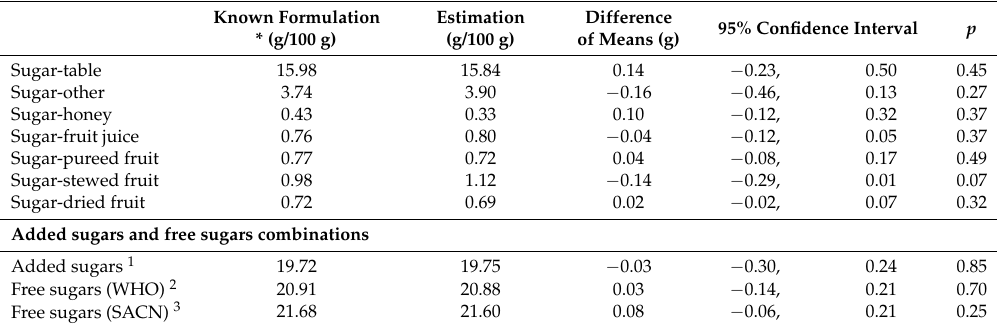
Table 2. Validation test results; the comparison of mean values between known formulations and their estimations using paired t -test ( n =